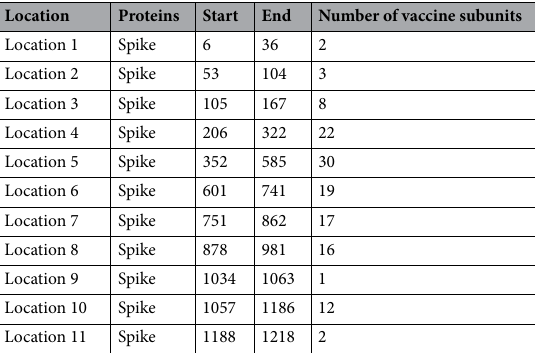
Table 3. DeepVacPred first round prediction results. Here we show the number of predicted vaccine subunits for each location.